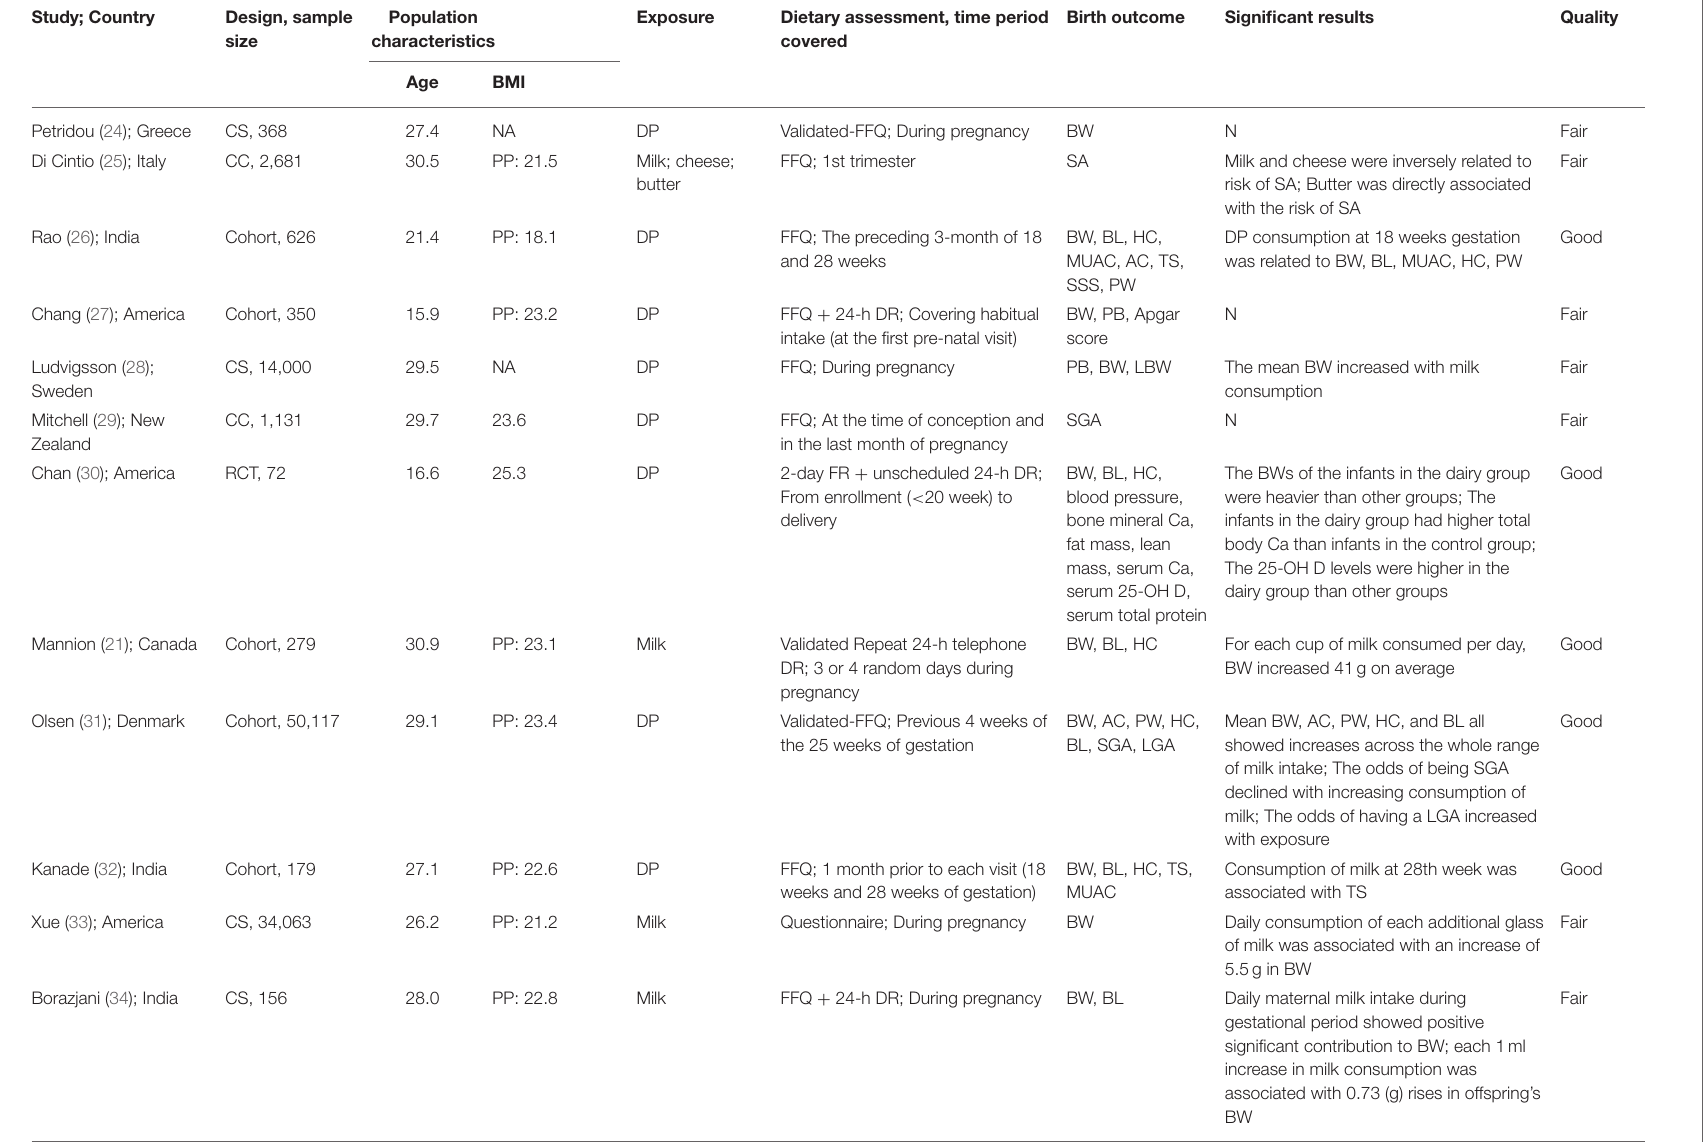
TABLE 1 | Characteristics of included